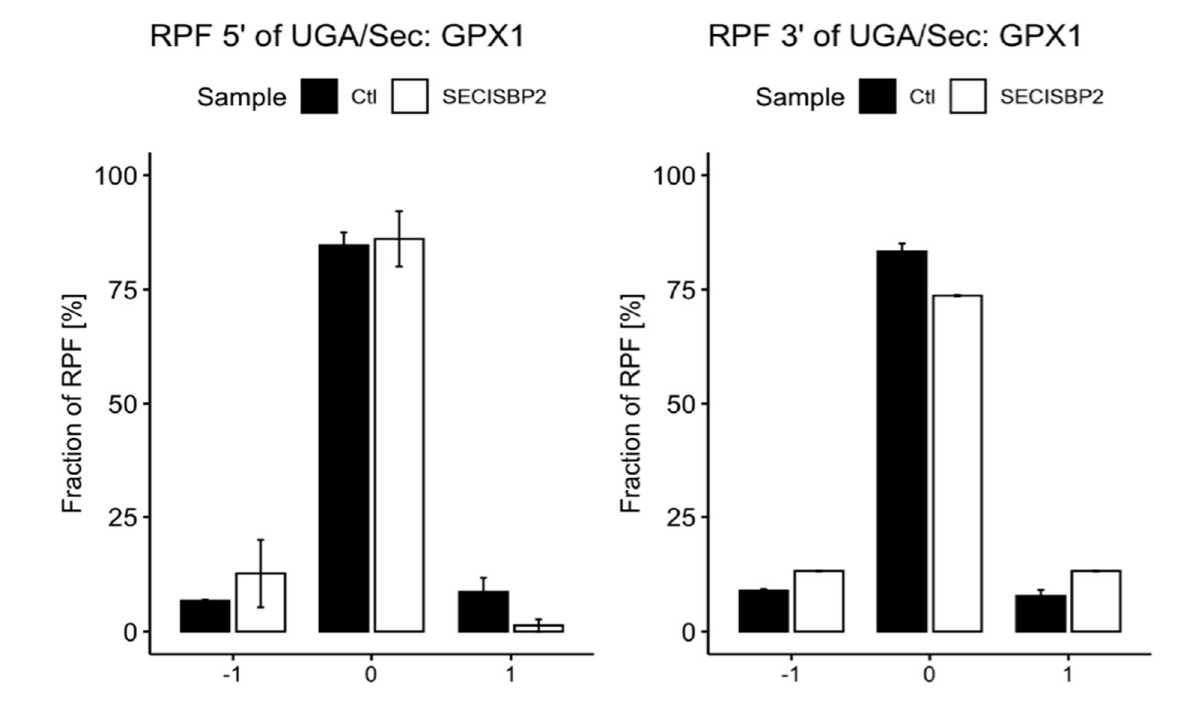
Figure A3. Size distribution of reads mapping to coding sequences of transcripts located in the cytoplasm and expressed in HAP1 cells. Reads around 21 nucleotides length represent “small” ribosomal footprints (sRPF, A-site not occupied) and reads of 28 nucleotides length represent “big” RPFs (A-site occupied). For pUGA and related measures, only reads of 20 + 21 and 28 + 29 nucleotides were selected, since in these RPFs, the first base of the P-site is 12 nucleotides from the 5 ′ end. These species are also the most abundant species in their respective peaks.